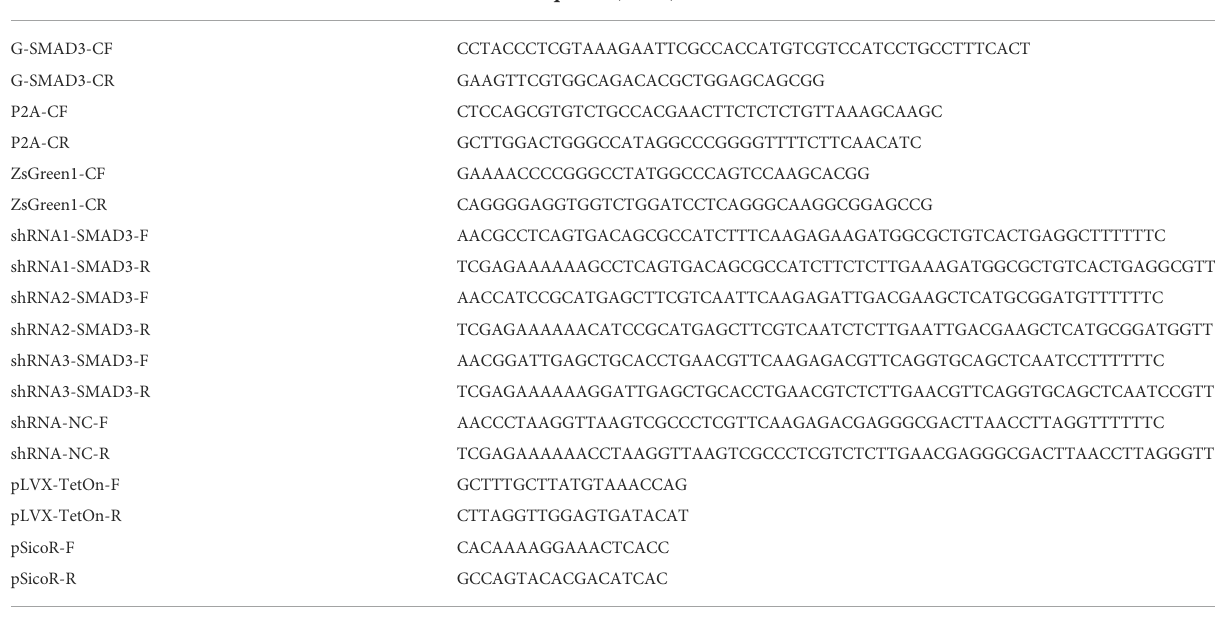
TABLE 1 Primers for vector construction and identi fi cation.